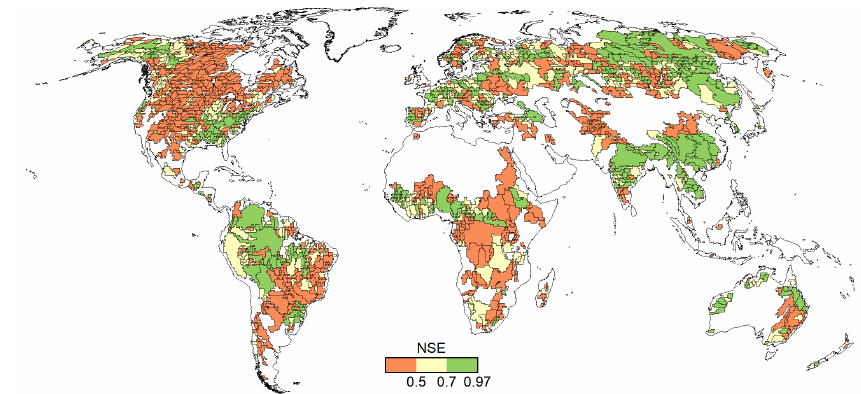
Figure 7. Classified NSE efficiency metric for the 1319 river basins in WaterGAP 2.2d.